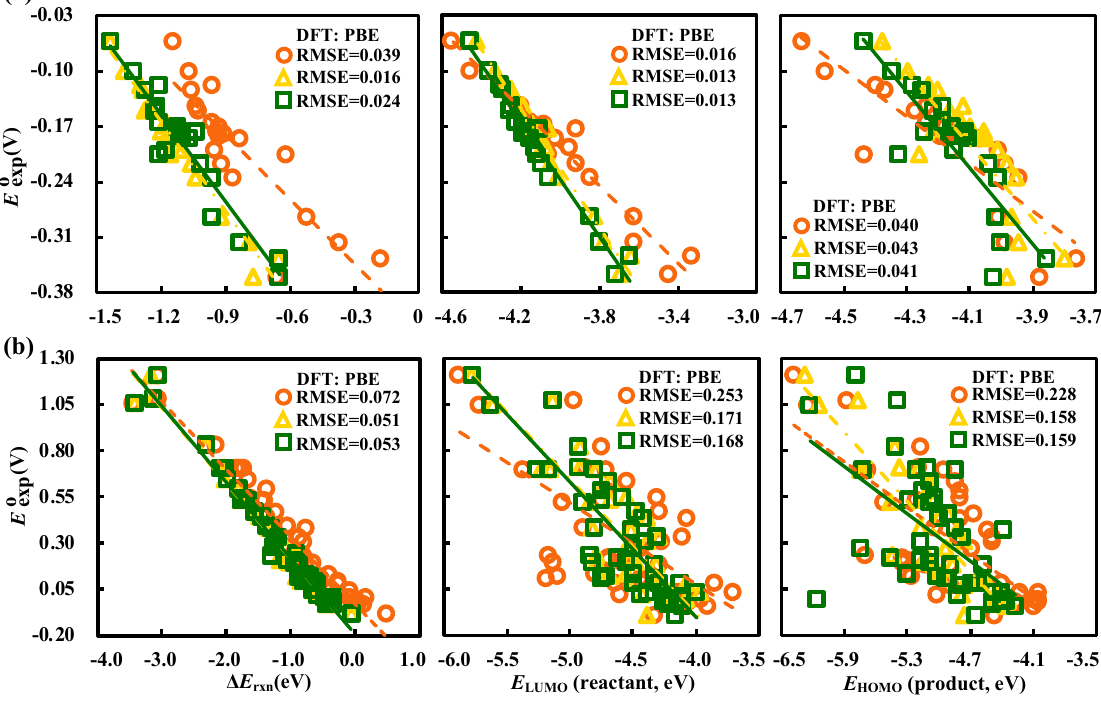
Figure 2. Scatter plots showing linear correlations of the PBE calculated (cid:31) E rxn , E LUMO , and E HOMO , versus the experimentally measured redox potentials ( E o exp ) for ( a ) alloxazine-based compounds, and ( b ) quinone-based compounds. The color orange represents both the OPT and SPE in gas-phase, the color yellow represents OPT in gas-phase followed by SPE with SOL, and the color green represents both OPT and SPE with